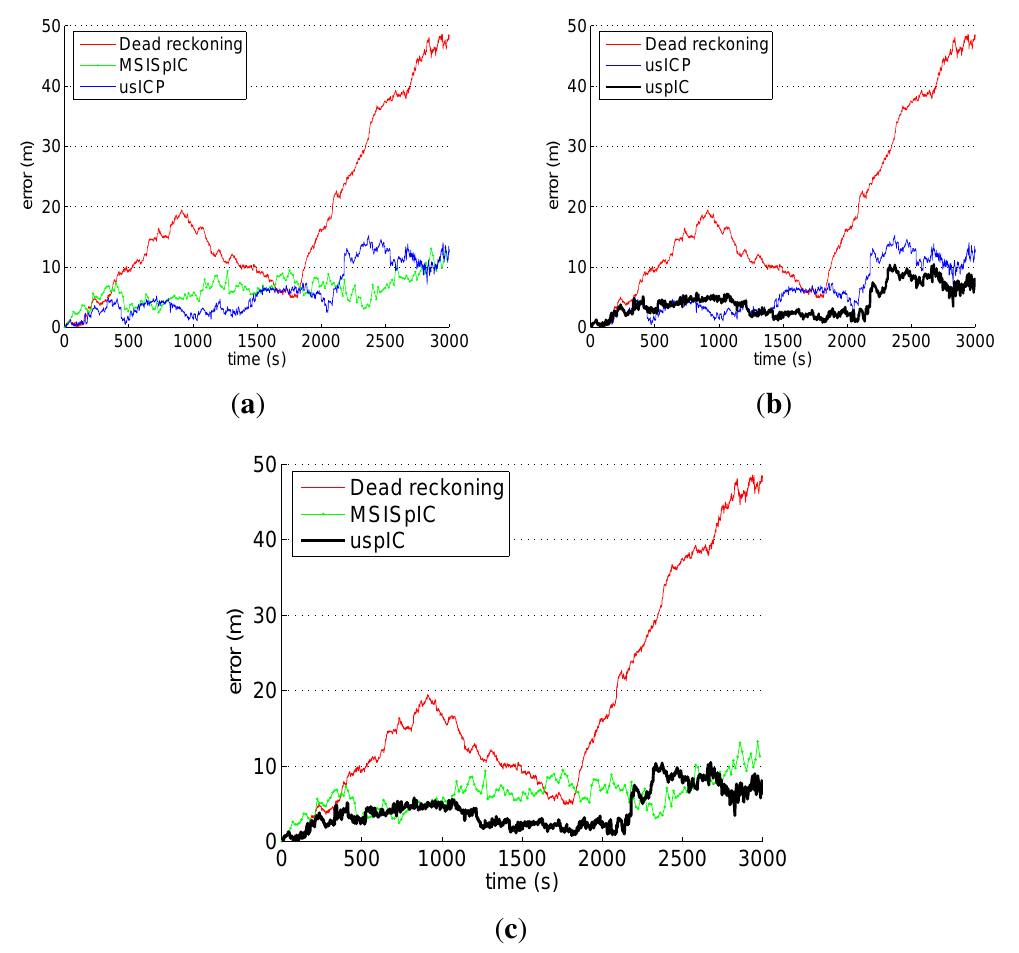
Figure 15. Quantitative evaluation, comparing dead reckoning with ( a ) MSISpIC and usICP; ( b ) usICP and uspIC; and ( c ) MSISpIC and